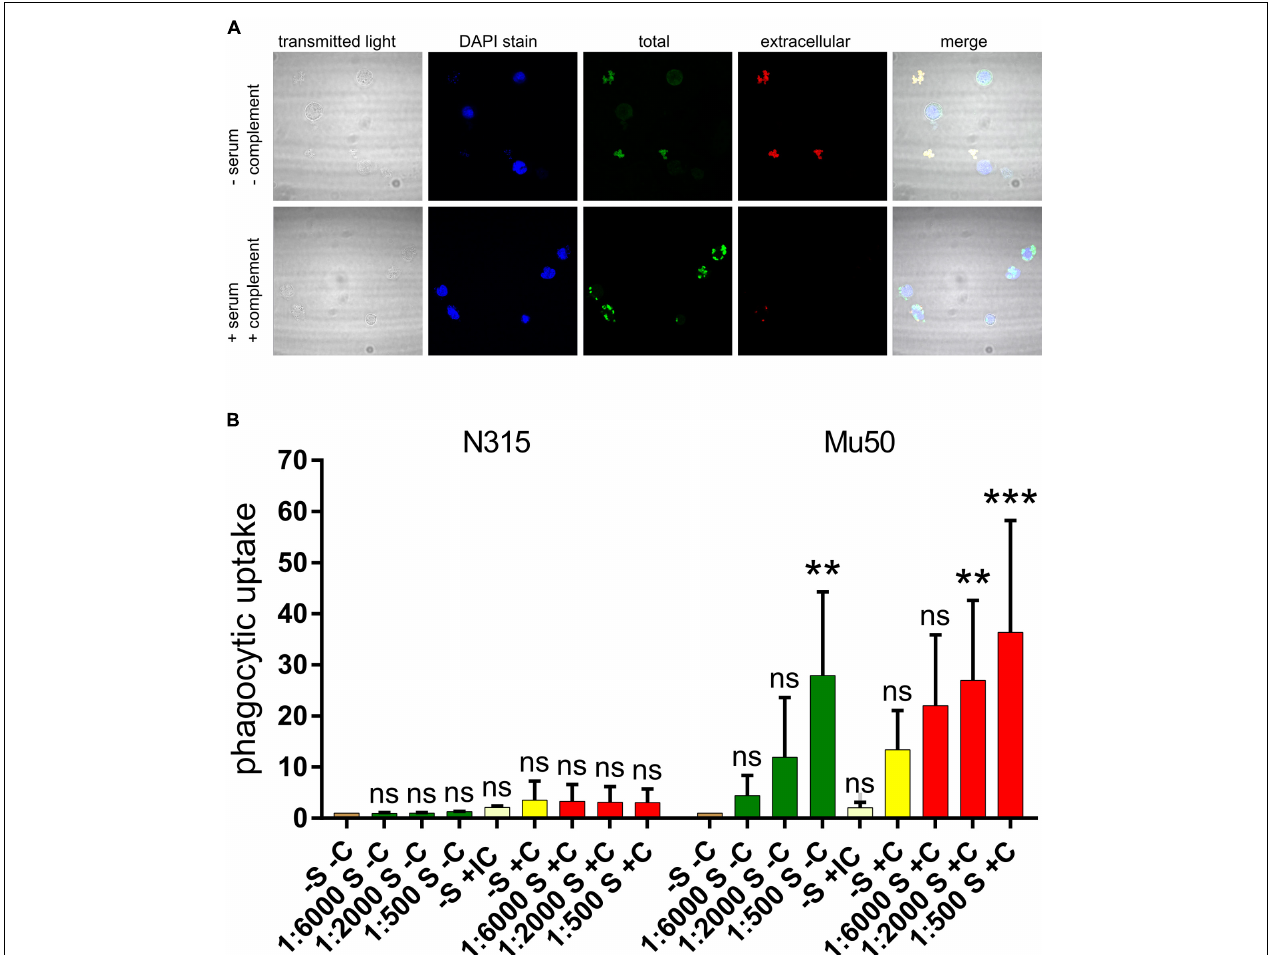
FIGURE 7 | Effect of capsule specific serum on Mu50 phagocytosis. Fixed bacterial cells were incubated with differentiated HL60 cells in the presence or absence of a source of complement and capsule-specific antiserum. (A) Confocal microscopy visualization of phagocytosis experiments. DAPI stain binds DNA and shows neutrophil nuclei and bacterial cells (with lower intensity). Total bacteria are shown by the staining after cell permeabilization, extracellular bacteria are shown by the staining before cell permeabilization. (B) Effect of capsule specific antiserum on SpA + and SpA - phagocytosis. The graph shows the fluorescence associated to neutrophils after phagocytosis of fluorescent stained bacteria, under different conditions. The phagocytosis was performed in absence of both serum and complement (–S –C), in absence of complement and in presence of different serum dilutions (S –C), in absence of serum and in presence of inactivated complement (IC), in absence of serum and in presence of complement (–S +C), or in presence of both complement and different dilutions of serum (S +C). Each experiment was normalized by the corresponding –S –C sample. The experiment was performed in triplicate, the error bars show the standard deviations. The graph reports the results of multiple comparisons obtained with a two-way ANOVA, in which each condition was compared to the –S –C reference sample. p -values are indicated as ∗∗ p < 0.005, ∗∗∗ p < 0.0005; ns, not